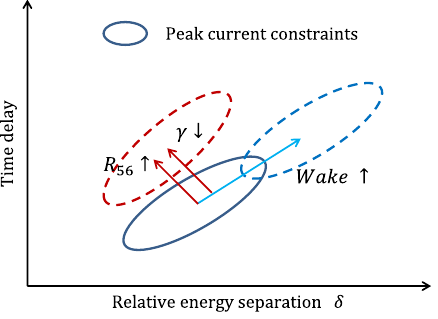
FIG. 11. Schematic of the three methods to acquire large time delay for the two-bunch compression